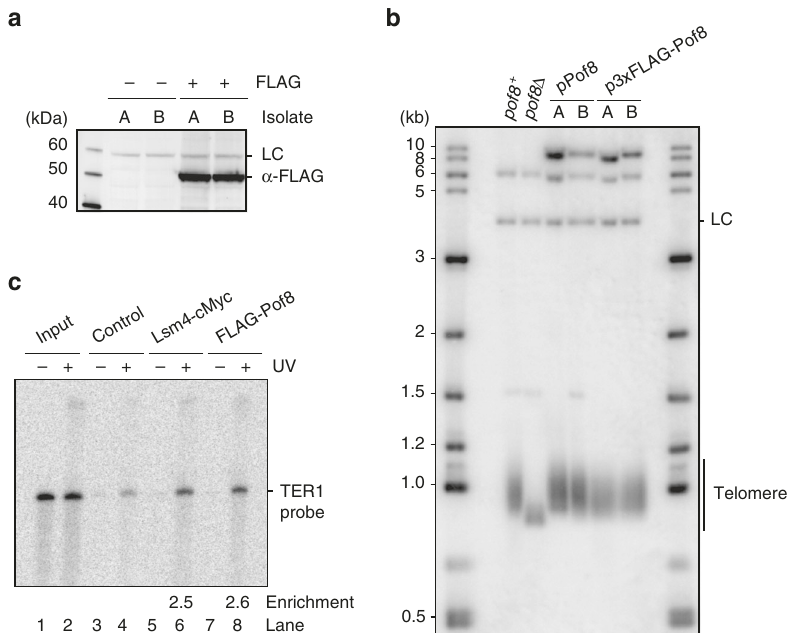
Fig. 5 Characterization of 3xFLAG-Pof8. a Western blot using α -FLAG antibody in strains containing untagged Pof8 or 3xFLAG-Pof8 with two independent isolates per strain in an Lsm4-cMyc background. A non-speci fi c band recognized by α -FLAG in S. pombe extracts even in the absence of an epitope-tagged protein was used as a loading control (LC). b Telomeric Southern blot from strains containing untagged Pof8 or 3xFLAG-Pof8 on a plasmid under the control of its endogenous promoter with two independent isolates per strain in an Lsm4-cMyc background. A rad16 + probe was used as the LC. c UV crosslinking and immunoprecipitation of in vitro transcribed TER1 probe incubated in extracts containing epitope-tagged Lsm4 or